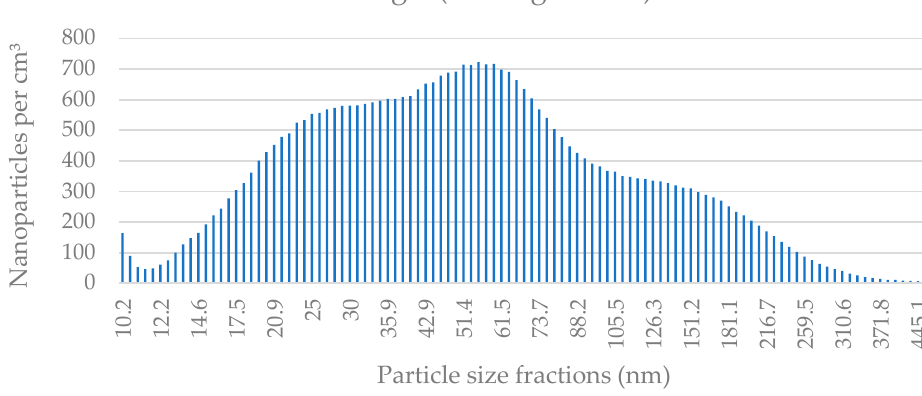
Figure A17. The average nanoparticle concentration in each size fraction in Building 9 during a one-week measurement period during the heating season.